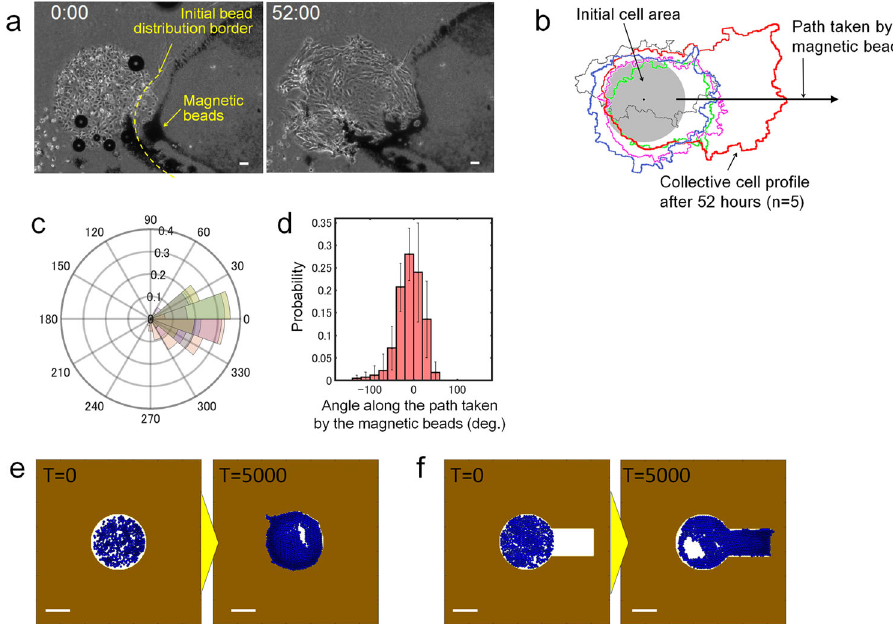
Fig. 6 Effects of arti fi cial modi fi cation of ECM resistance force on the directionality of collective cell migration. a Time-lapse images of collective cell migration when the ECM was arti fi cially modi fi ed by magnetic bead manipulation. Repetitive manipulation of magnetic beads by a permanent magnet partially weakened the resistance force from the ECM at the speci fi c location. b Collective cell boundary after 52 hours. Five culture experiments were conducted ( n = 5) and each colour pattern represents the result of one collective cell pro fi le. Cells were initially patterned in the shape of a circle, but many of the cells migrated towards the area weakened by the magnetic beads. c Polar histogram of the probability of angle of cell location from the centre of the initial circular shape after 52 hours. Five culture experiments were conducted ( n = 5). d Probability of the movement of cells out of the initial circular area as a function of the angle along the axis of the path of the magnetic beads. Approximately 75% of the cells migrated towards the area degraded by the magnetic beads. Five culture experiments were conducted ( n = 5), and on average over 30,000 data points per experiment were obtained to calculate the probability. The data shown are the means ± SDs ( n = 5). e Computational simulation result without pre-made degradation area in the ECM surrounding the collective cells. f Computational simulation result with pre-degraded area in the ECM surrounding the collective cells. The complete time-lapse movies for Fig. 5a, e and f are shown in Supplementary Movies 12 – 14. Scale bar: 100 μ m ( a ), 500 μ m ( e , f